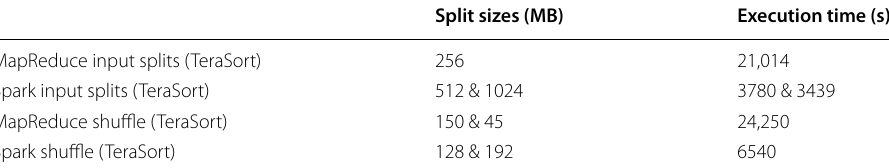
Table 6 The best execution time of MapReduce and Spark with Terasort workload Split sizes (MB)